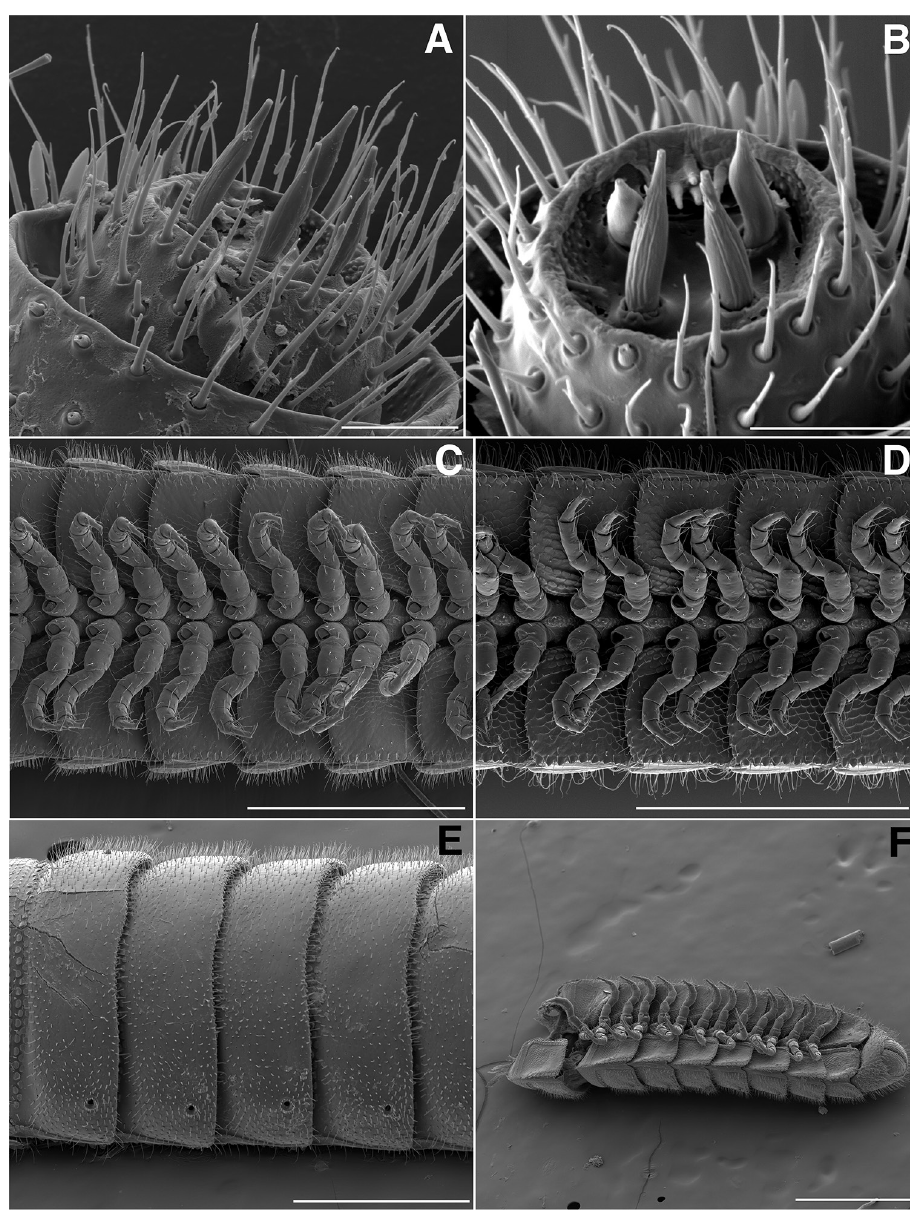
Figure 15. A Antennomere 7 of I. tobini sp. n. (scale bar 20 µm) B the same of I. plenipes (scale bar 20 µm). C Ventral view of rings of I. tobini sp. n. (scale bar 400 µm) D the same of I. plenipes (scale bar 400 µm). Illacme tobini sp. n.: E dorsolateral (left) view of rings 10–14 (scale bar 300 µm) F ventrolat- eral (right) view of posterior rings (scale bar 500 µm) (Catalog #s: I. tobini sp. n. MPE00735, I. plenipes